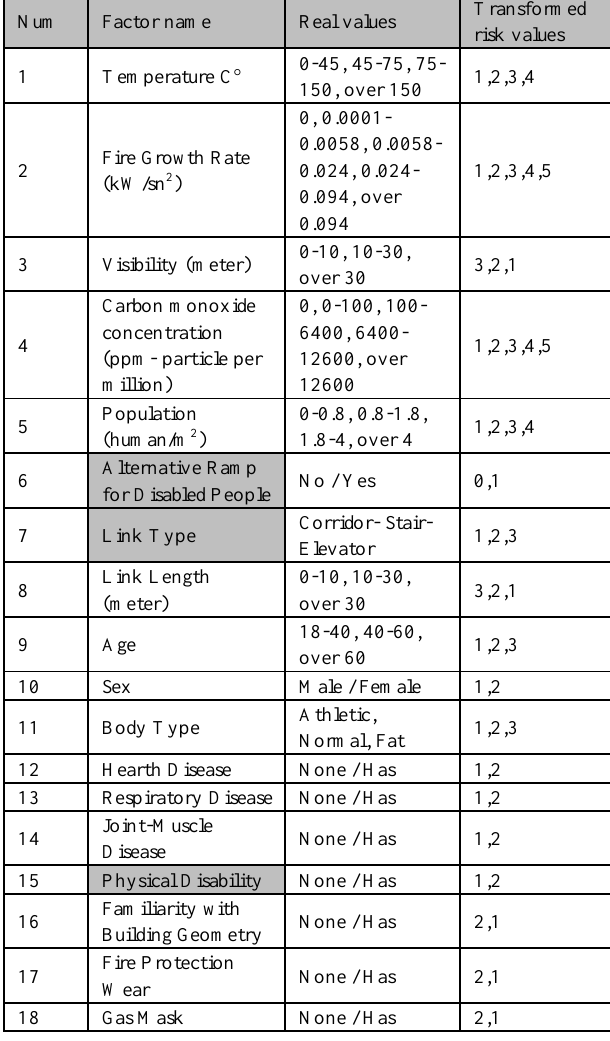
Table 3. Used factors and their risk values.